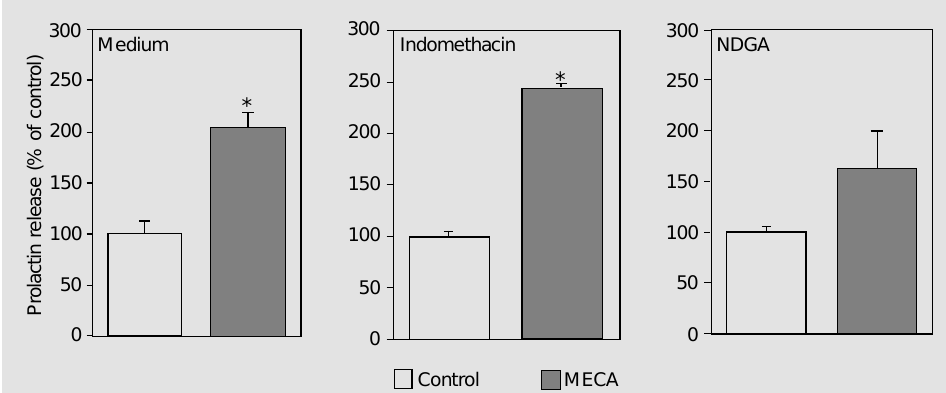
Figure 6. Effect of 25 nM 5-N- methylcarboxamidoadenosine (MECA) on prolactin release in the absence or presence of 10 µM indomethacin or 10 µM nor- dihydroguaiaretic acid (NDGA). Data are reported as means ± SEM (N = 5). *P<0.001 com- pared to control (Student t